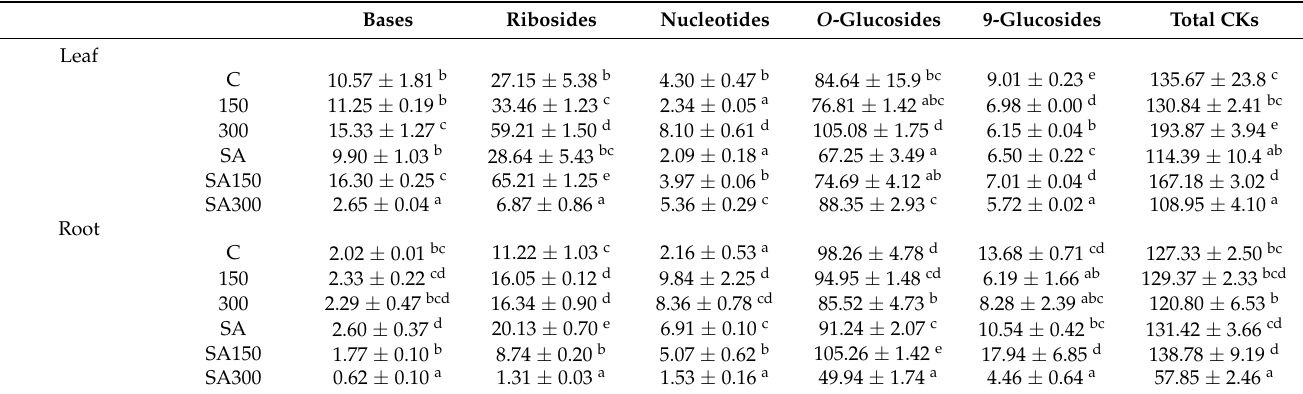
Table 2. Effect of salicylic acid (SA) pre-treatment on endogenous cytokinin levels (pmol g − 1 FW) in Hordeum vulgare L. ‘Ince-04 (cid:48) plants grown under control or saline conditions (150 and 300 mM NaCl). Values are mean ± SE ( n = 6). The data with different letters in the same column at superscript are significantly different ( p < 0.05).